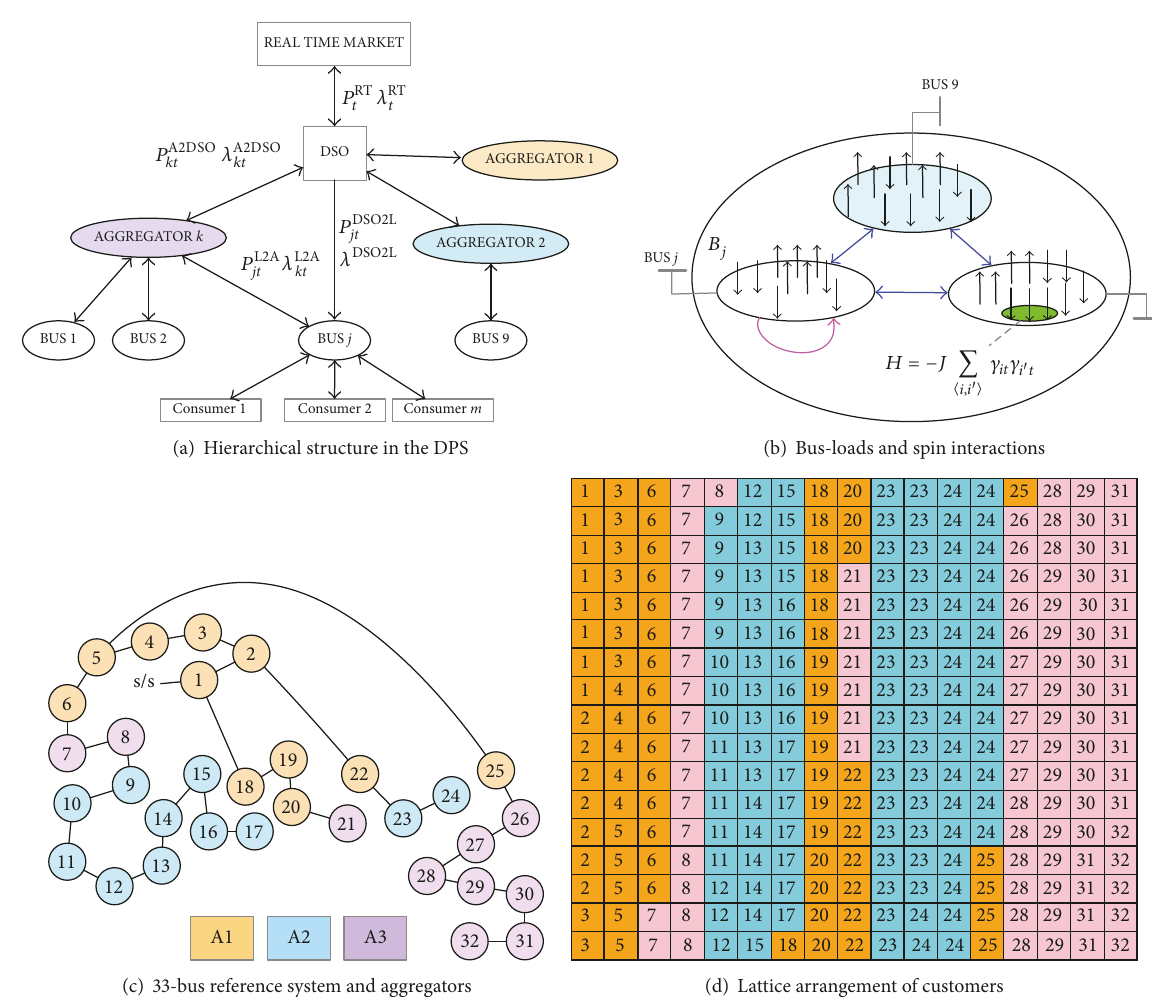
Figure 1: Power exchange and the spin model. Each bus in (a), (c) groups customers interacting through the Ising Hamiltonian with binary states represented by up/down arrows (b). Aggregators share the demand in the bus-loads (c) and customers are arranged into a 2D lattice (d) in a way that preserves the bus distance